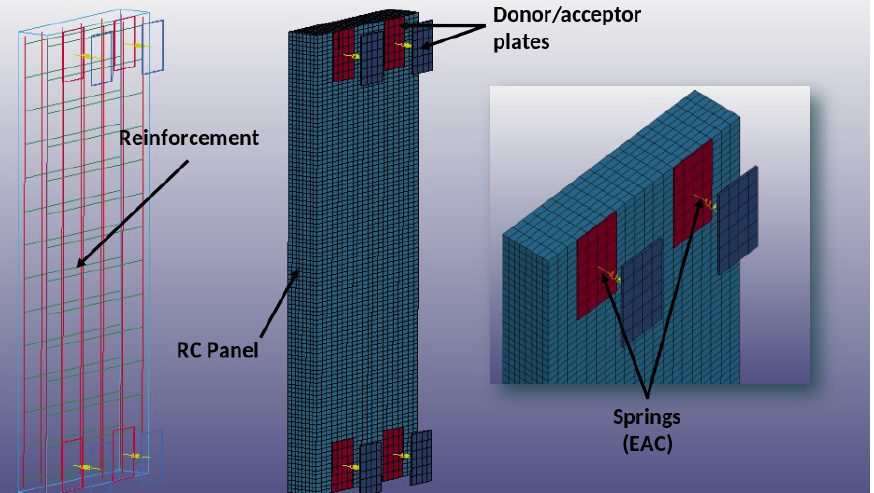
Figure 16. FE numerical model of the energy absorbing